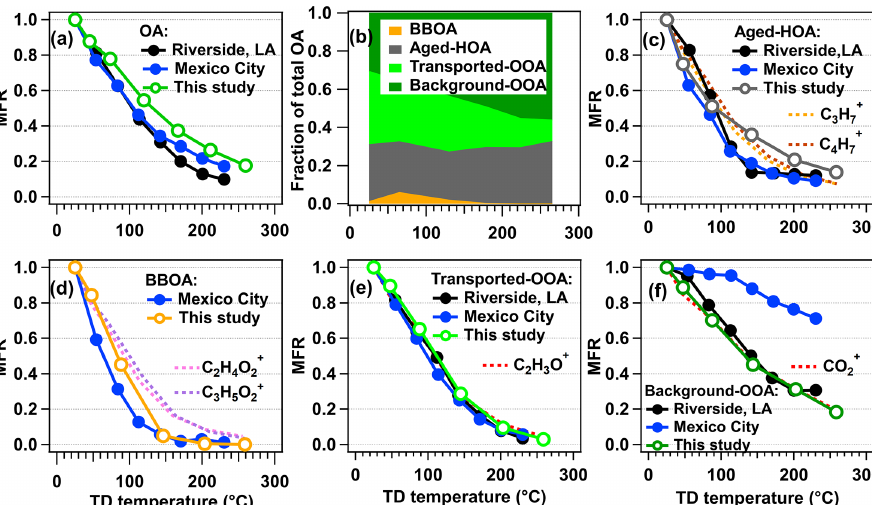
Figure 7. (a) Thermogram of total OA; (b) fraction of four factors in total OA as functions of TD temperature; MFRs of (c) aged-HOA, (d) BBOA, (e) transported-OOA, and (f) background-OOA. For comparison, the MFR curves observed in other campaigns, such as Riverside, Los Angeles, USA, and Mexico City, Mexico (Huffman et al., 2009a), are also shown together due to their similar residence time in TD, which are marked by solid black and blue circles, respectively.